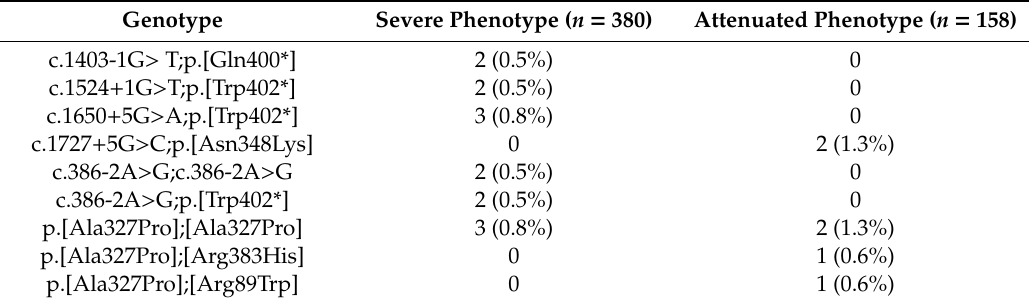
Table 3. Genotype–phenotype correlation in MPS